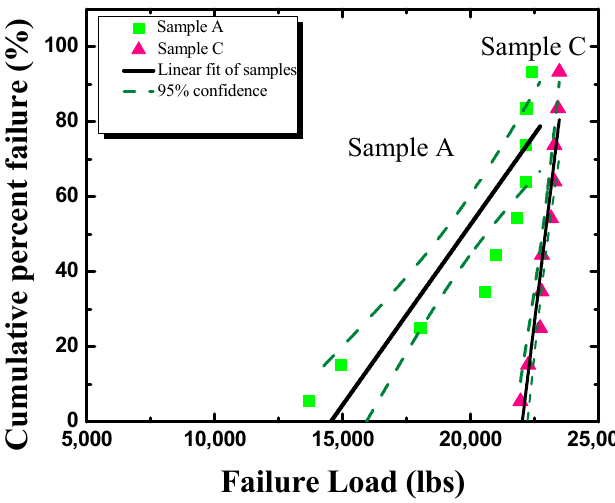
Figure 6. Cumulative probability of failure of the samples based on the thermal and mechanical load test (T&M) of the porcelain insulators.